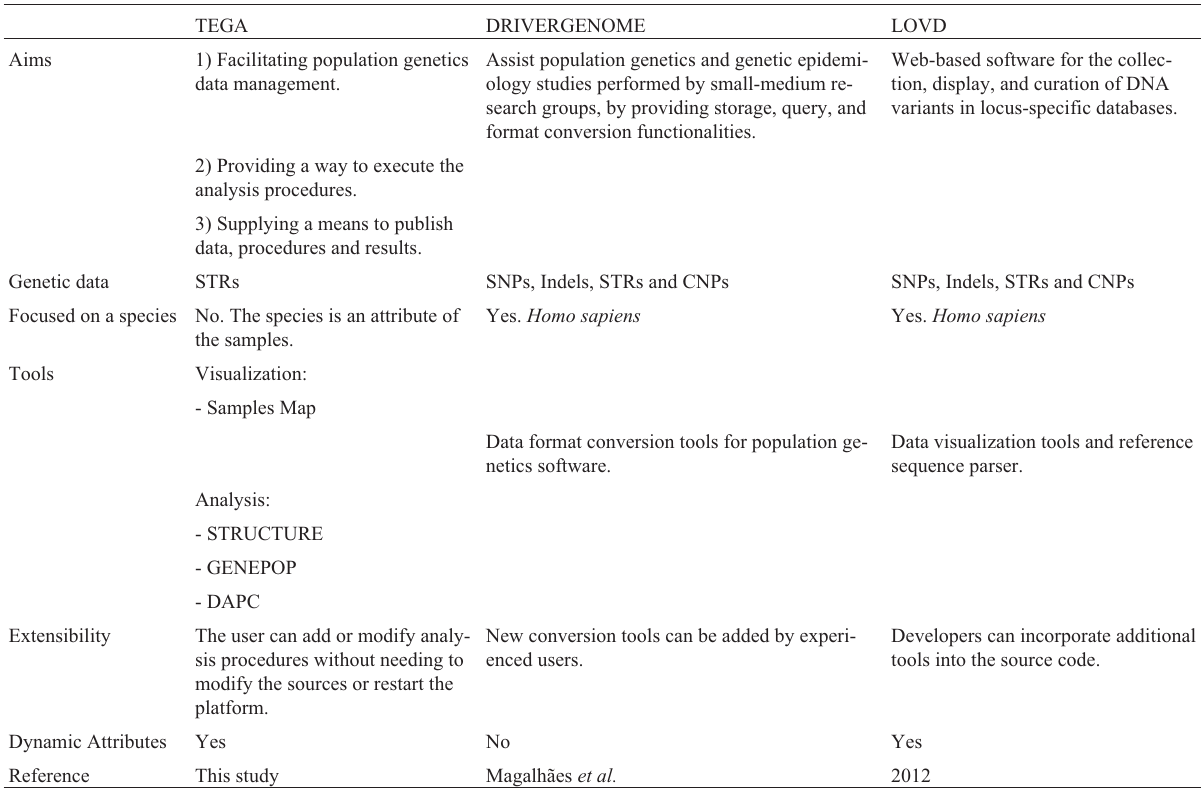
Table 1 - Platforms for populations genetic data